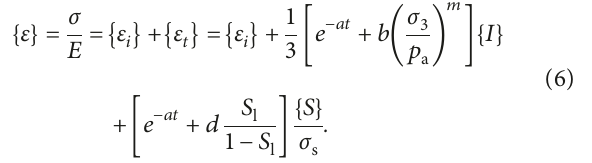
Figure 12: Location of slab fracturing in the phase I